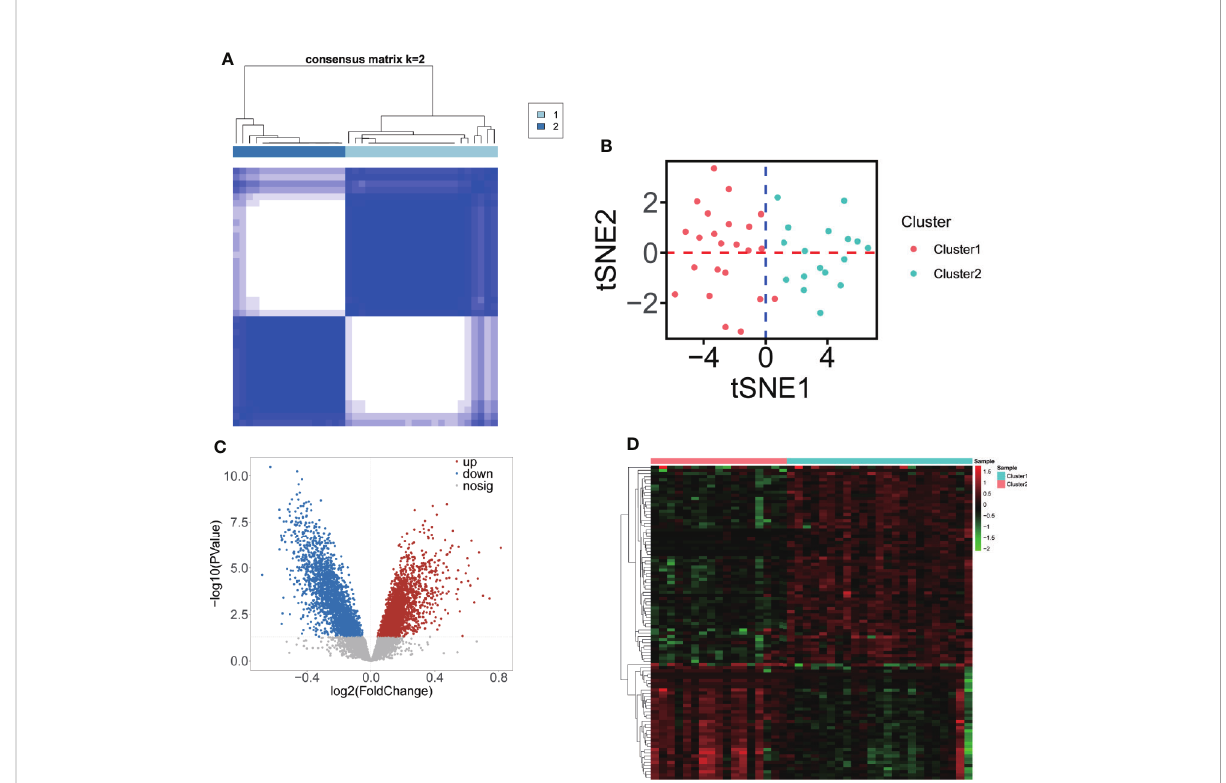
FIGURE 3 Classi fi cation of two m6A-related molecular subclusters for OP based on 13 DE-m6A regulators. (A) Heatmap showing the consensus clustering of m6A-related subclusters ( k = 2) of OP based on 13 DE-m6A regulators. (B) The t-SNE plot showing the two clustered samples in the OP. Red represents cluster 1, and blue represents cluster 2. (C) Volcano plot showing the DEGs between two m6A-related subclusters. (D) Heatmap indicating the top 100 DEGs between two m6A-related